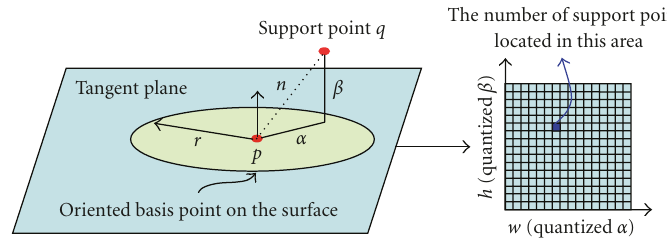
Figure 3: The demonstration of spin image.